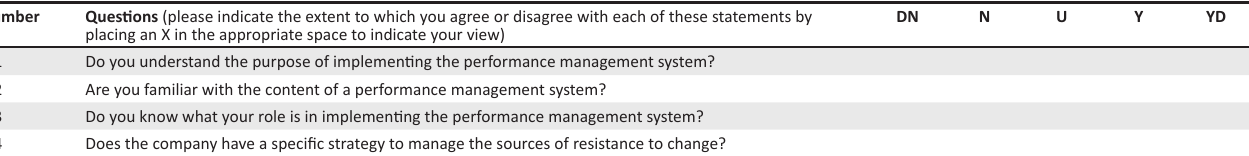
TABLE 2: Example of the scale used.